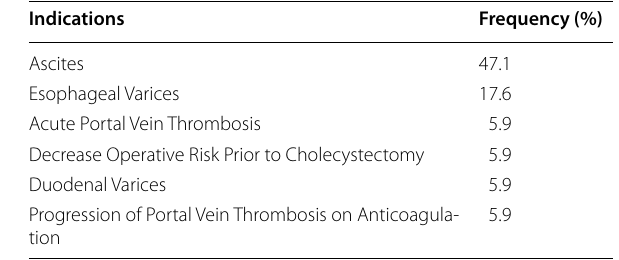
Table 1 Demographic Characteristics Table 2 Indications for TIPS